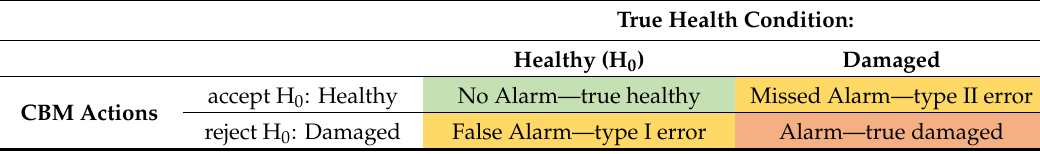
Table 9. Type I and II errors in hypothesis testing for condition-based maintenance (CBM). True Health Condition: